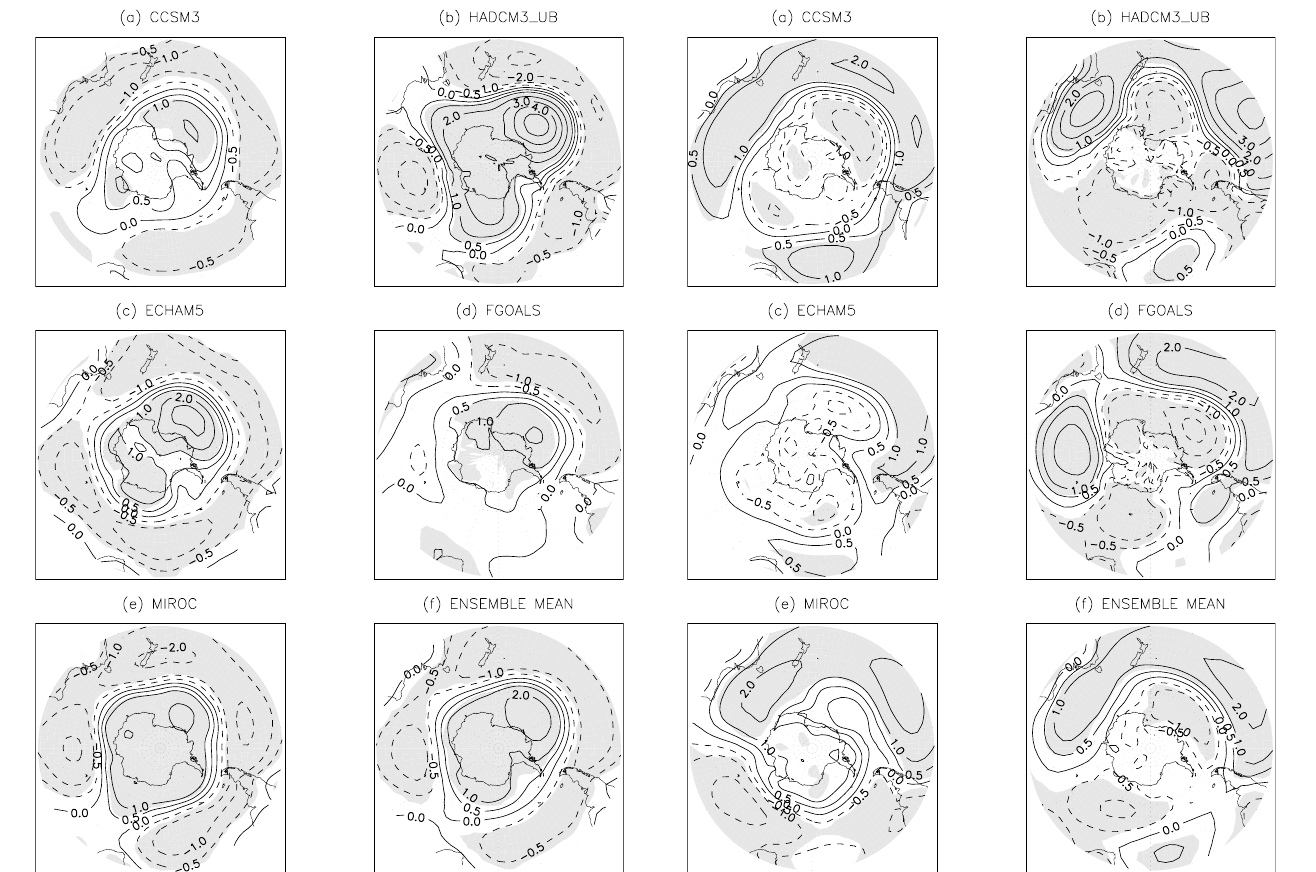
Fig. 11. The SON mean difference in sea level pressure (hPa) be- tween the PMIP2 Mid-Holocene and control runs for (a) CCSMS3, (b) HadCM3 UB, (c) ECHAM5, (d) FGOALS, (e) MIROC and (f) the ensemble mean. Refer to Table 1 for more details on each model. Solid (dashed) lines indicate positive (negative) changes and statistically significant changes ( p ≤ 0.05) are shaded